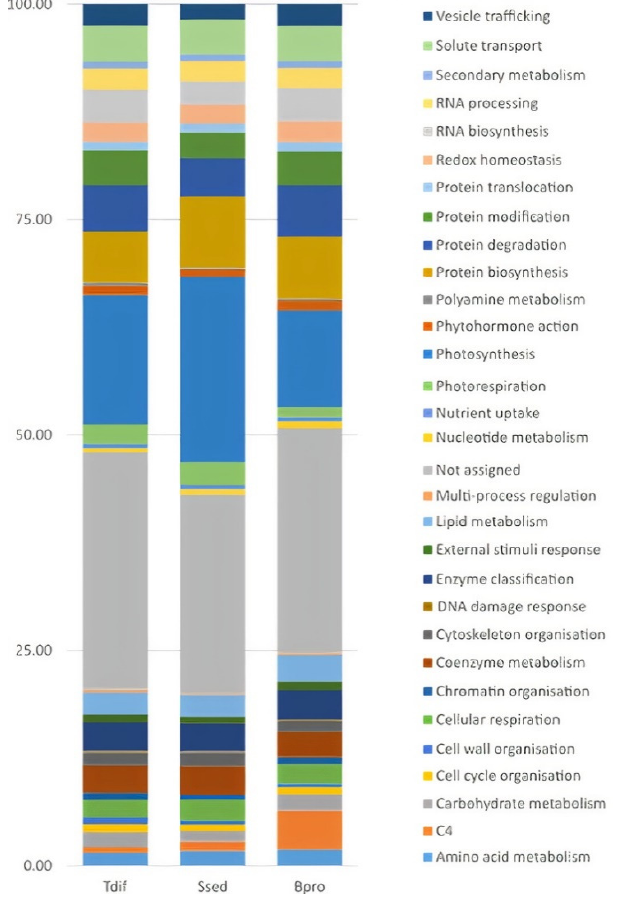
Figure 2. Distribution of transcriptional investment defined as the percentage of all transcripts belonging to a particular MapMan4 category [29] and the additional categories ‘C 4 ′ .